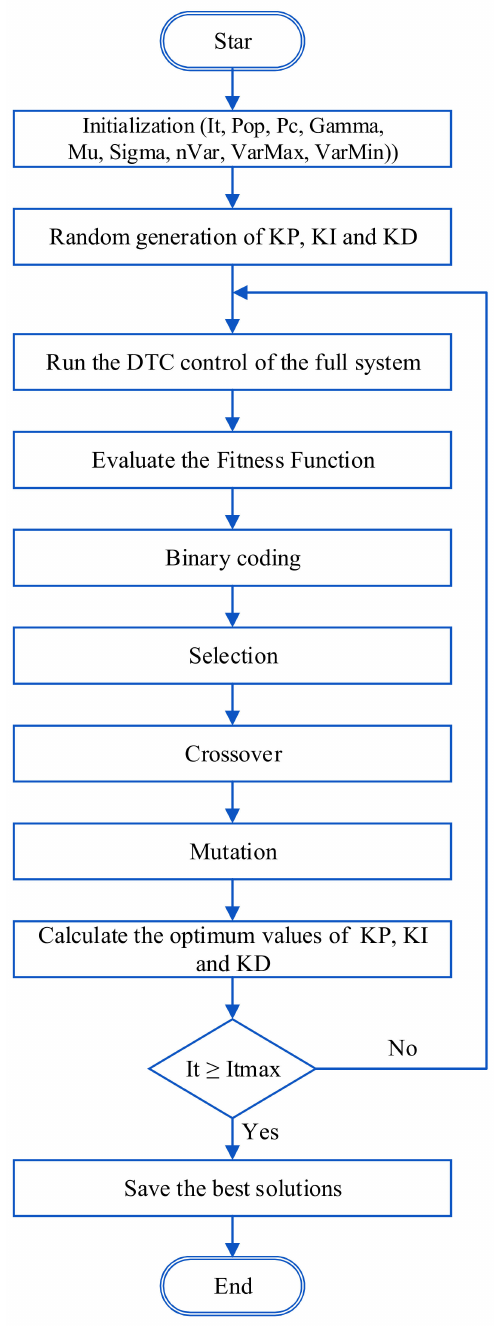
Figure 4. Flowchart of the